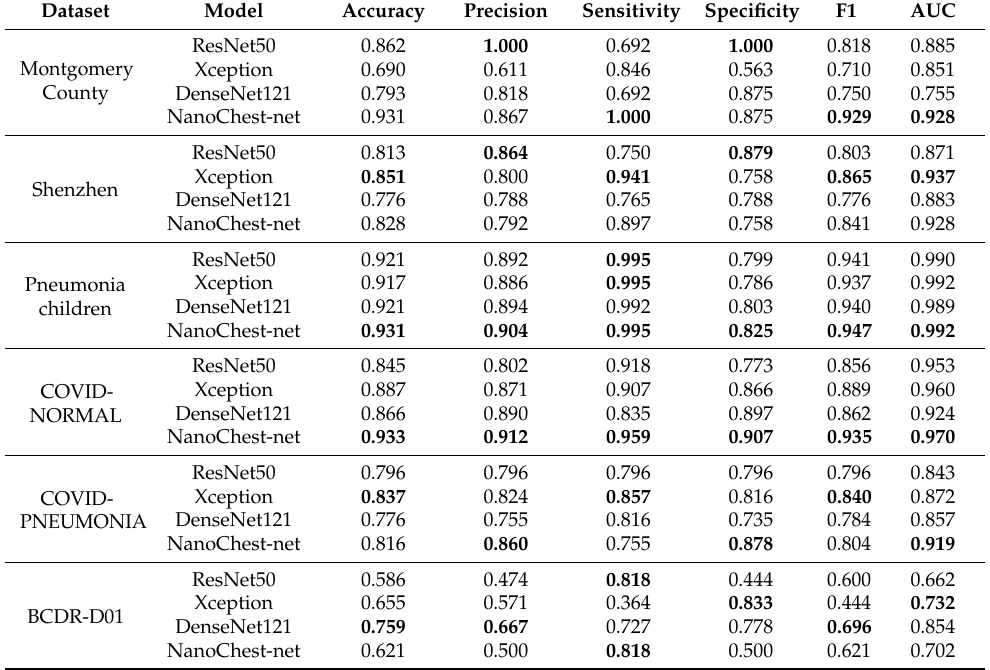
Table 8. Metrics of CNN models over all